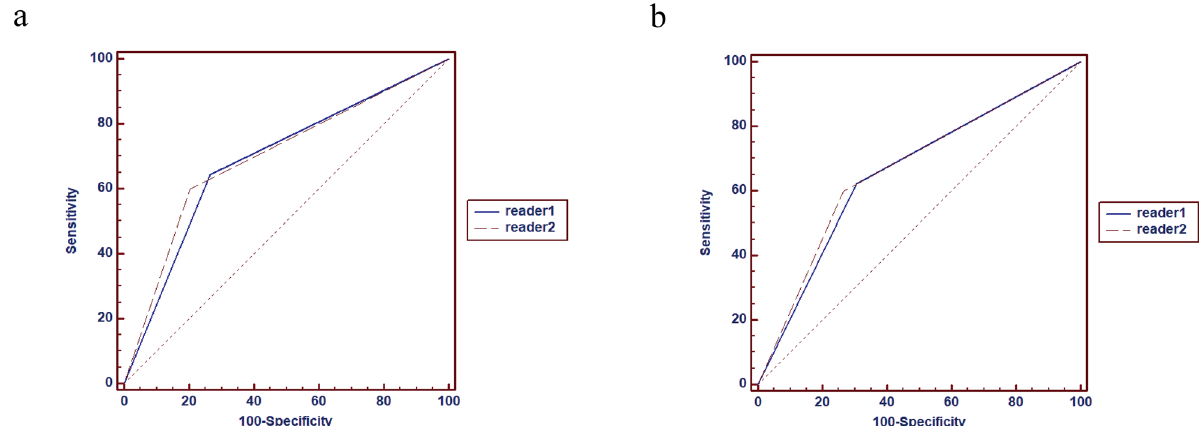
Figure 6. ROC curves for the differential diagnosis of primary and secondary ICH based on radiologists’ reading. The classification results of human readers 1 and 2 for the VOI ( a ) and three-layer ( b ) sketching methods.